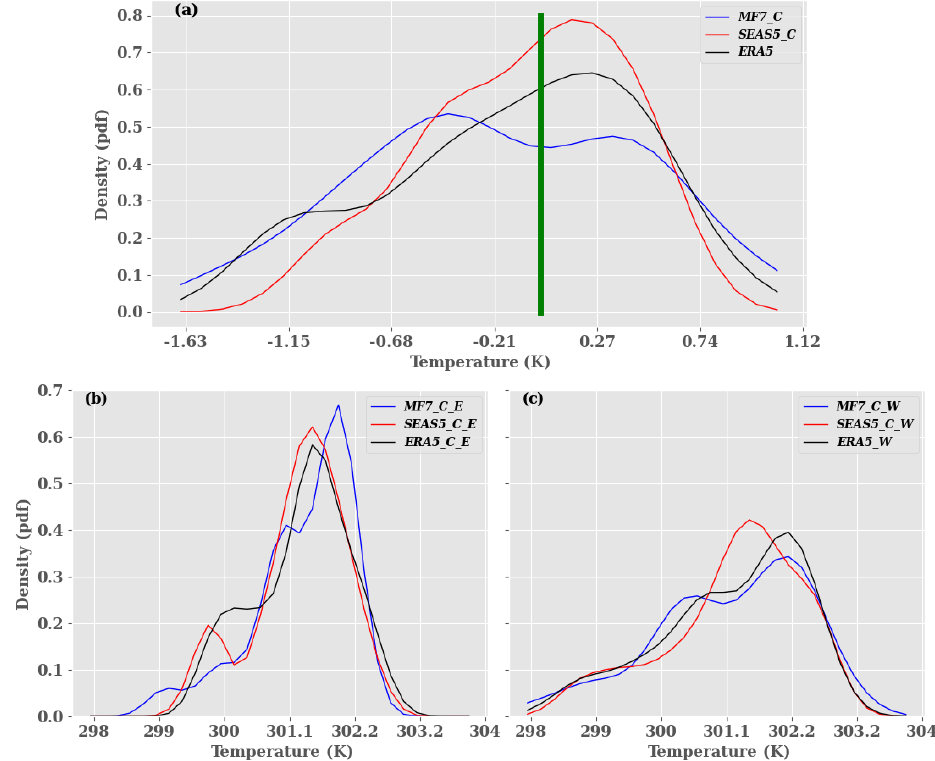
Figure 11. Distribution of the climatology over the period 20 June–17 September from 1993 to 2016 at June lead time 0 for (a) the dipole which represents the difference between heat low west and heat low east, (b) heat low east, and (c) heat low west. MF7_C and SEAS5_C refer to the MF7 and SEAS5 forecasts respectively corrected with the CDF-t method. ERA5_E, MF7_C_E and SEAS5_C_E refer to the HLE in the reanalyses and MF7 SEAS5 forecasts respectively corrected with the CDF-t method. “ERA5_W”, “MF7_C_W” and “SEAS5_C_W” refer to the HLW in the reanalyses and MF7 and SEAS5 forecasts respectively corrected with CDF-t method. The y axis indicates the probability of occurrence and x axis the temperature in kelvins. The vertical green bar represents the boundary between the HLE and HLW phases. The analysis was carried out using the unperturbed